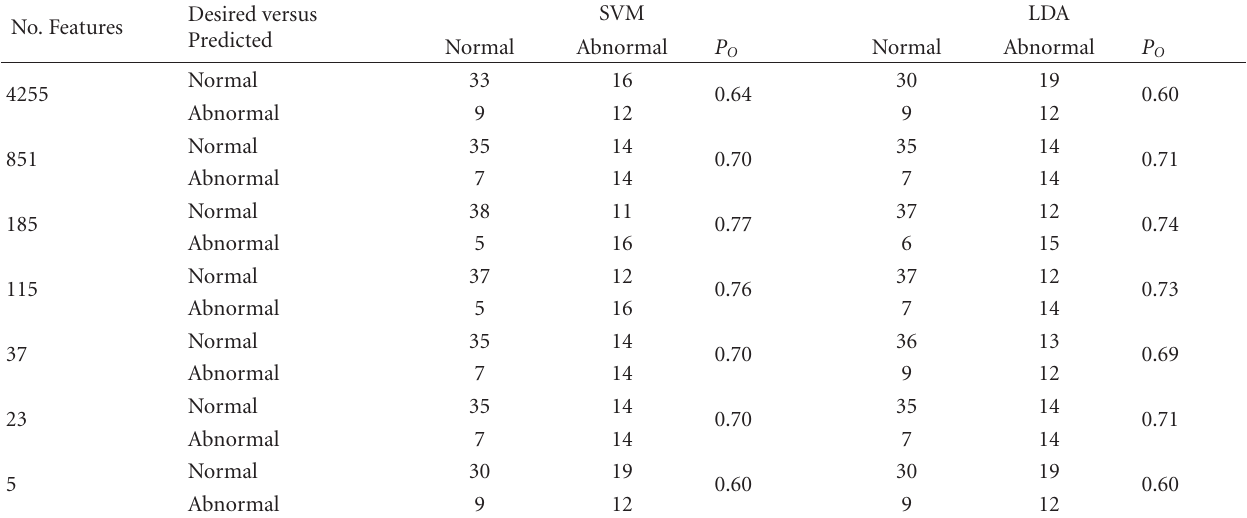
Table 4: Validation patterns ( X V ) confusion matrices for benchmark classifiers using averaged features. No.